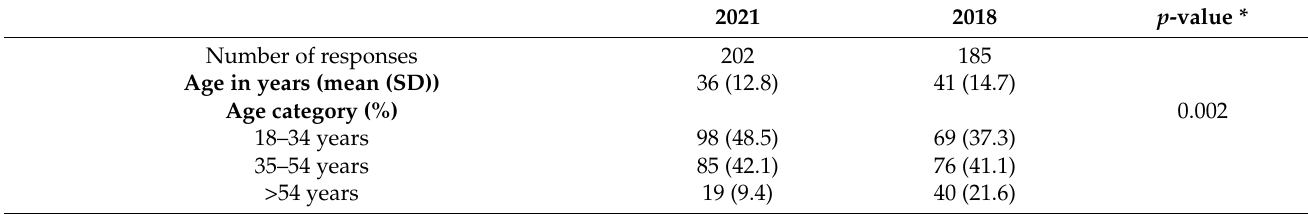
Table 1. Demographic characteristics of survey respondents (2018 and